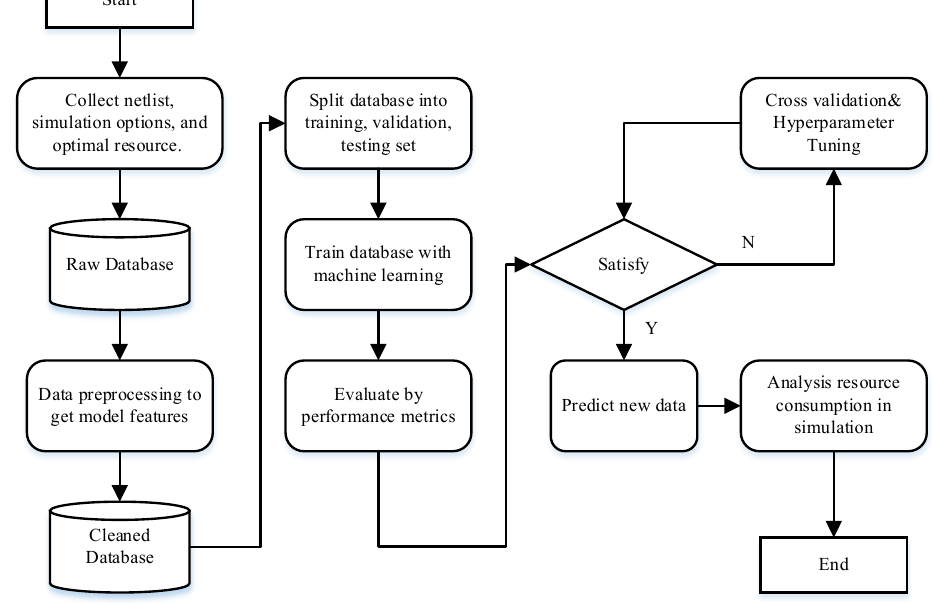
Figure 2. Workflow for implementing machine learning models for resource prediction.